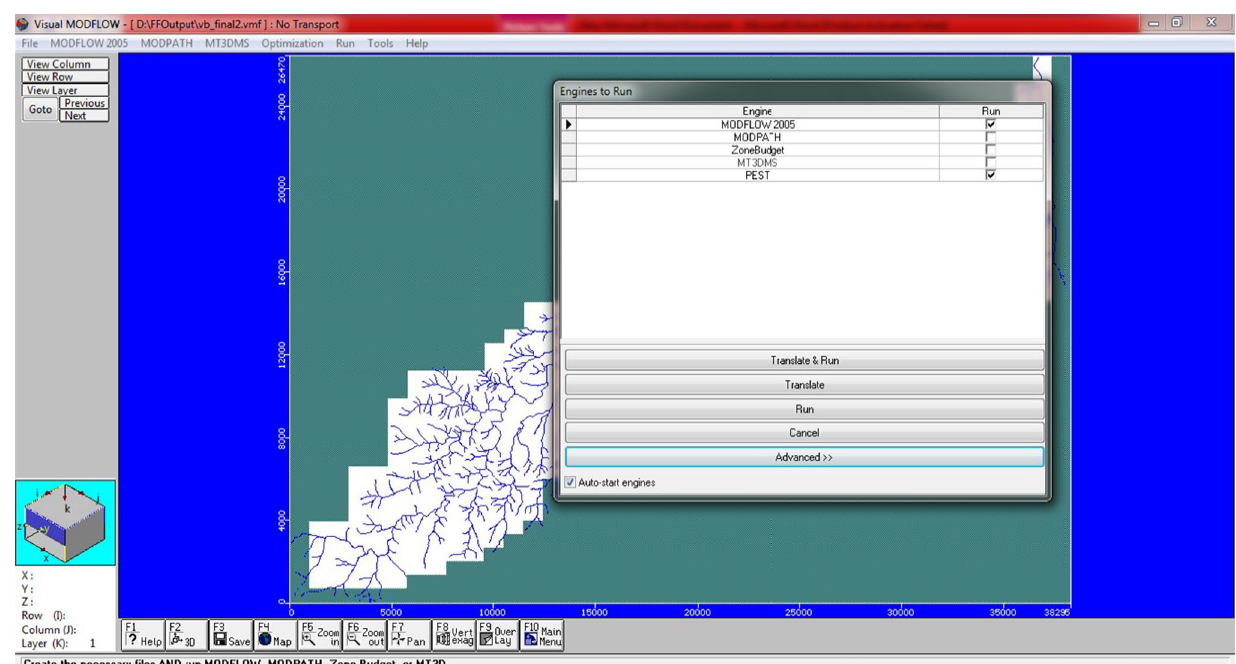
Fig. 5 Active, inactive flow, head wells, and observation wells in the modeling